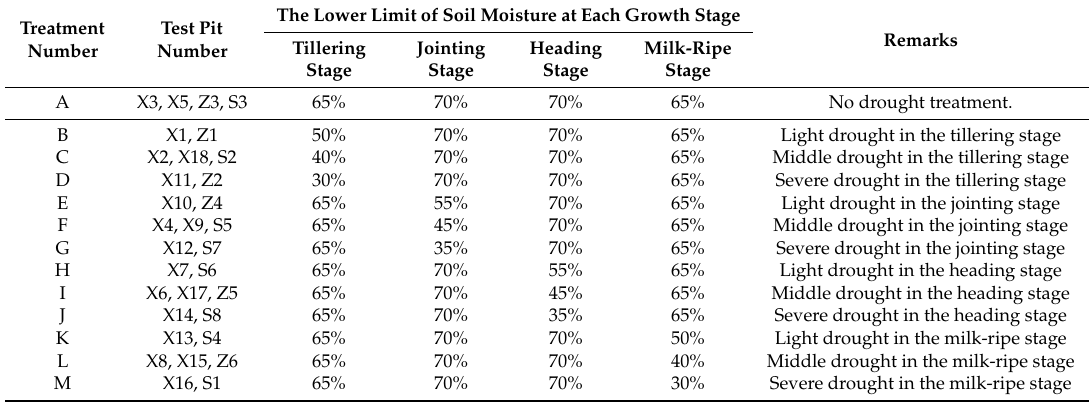
Table 1. Different treatment schemes for wheat drought experiments at Xinmaqiao test